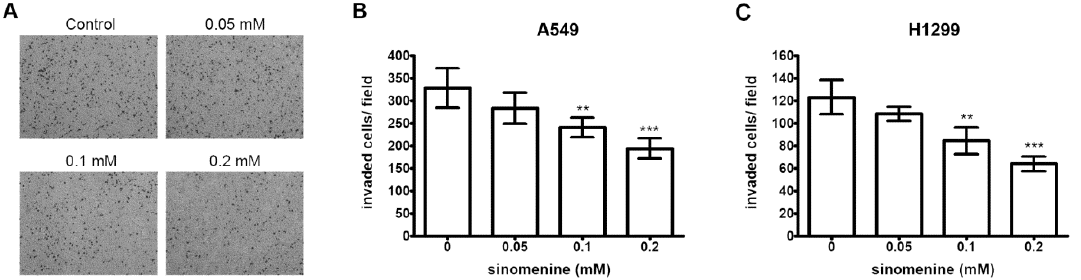
Figure 3. E ff ect of sinomenine on the invasion of A549 and H1299 cells. ( A ) A549 cells were treated with various concentrations of sinomenine for 24 h and cell invasion assay was performed. The invaded cells were photographed (200 × magnification). The invaded A549 cells ( B ) and H1299 cells ( C ) were counted in five random fields in each treatment, and data were calculated from three independent experiments. Data are presented as mean ± S.D. of three independent experiments. ** p < 0.01, *** p < 0.001 compared with the untreated control.